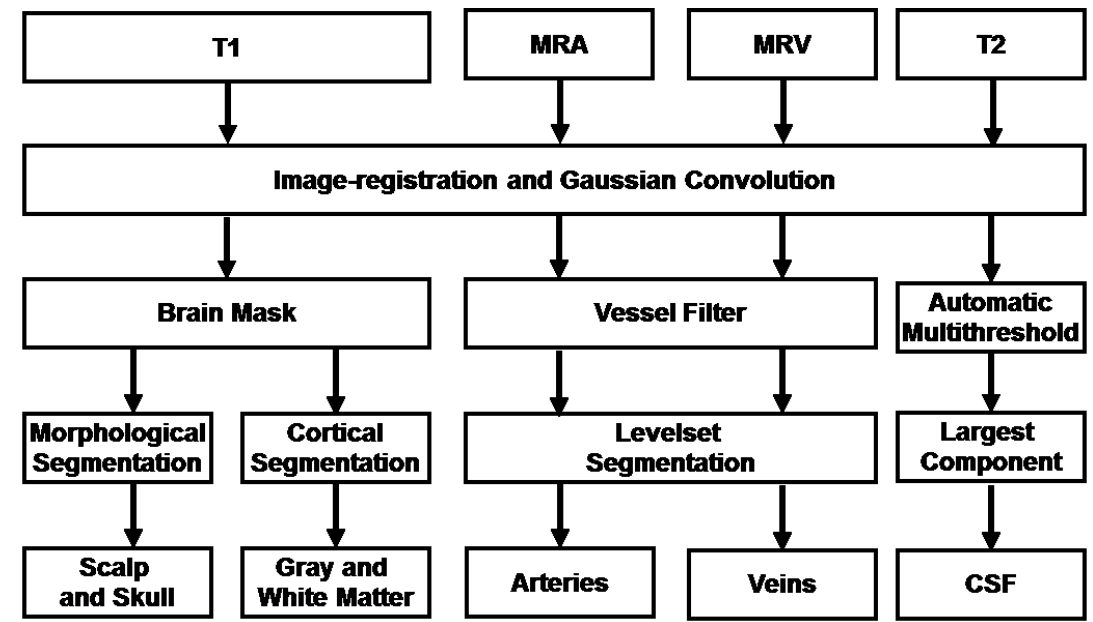
Figure 1. Proposed image processing pipeline for automatic reconstruction of subject-specific computational meshes. All medical images were convolved with a Gaussian operator for removal of inhomogeneity. Magnetic resonance angiography and venography is filtered for removal of non-vascular tissues and enhancement of vascular tissues. The filtered image is processed with marching cubes algorithm for capturing Cartesian coordinates of the vessel wall and maximal inscribed sphere is used to determine the centerline and diameter of the vascular network. T1 images are inputted into Freesurfer for segmentation of the grey and white matter as binary image matrices along with an image mask of skull and scalp. The image mask is processed with morphological operations to delineate contiguous surfaces of skull and scalp. CSF is identified using automatic thresholding and subtraction of other identified